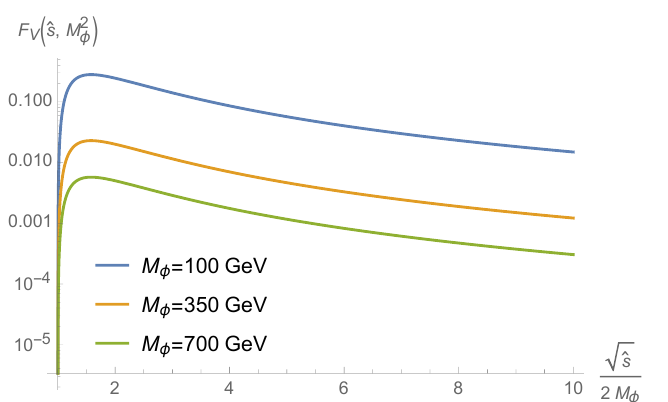
) entering the partonic cross section for electroweak Drell-Yan (cid:30)